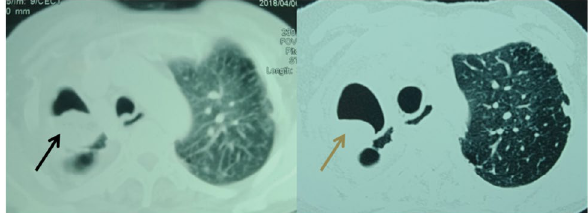
Figure 1: CT scan of chest (pre and post intrabronchial Voriconazole instillation) showing decrease in size of aspergilloma (arrow) in RUL cavity after four session of Voriconazole